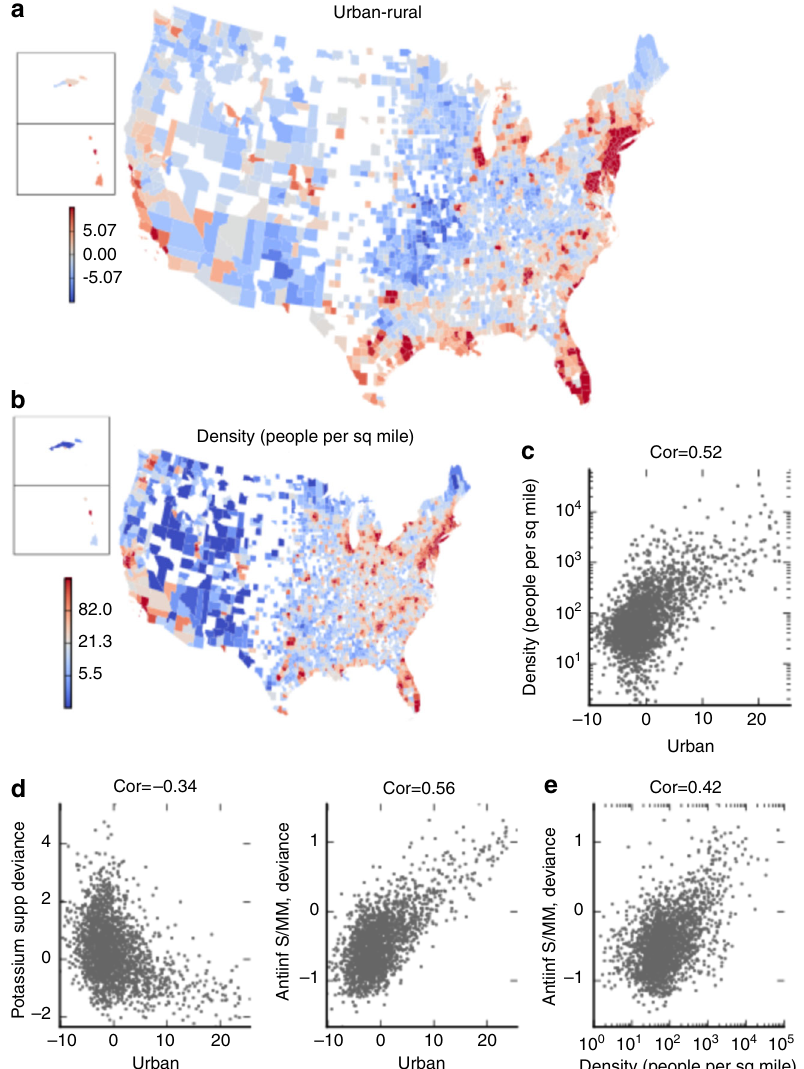
Fig. 2 Visualizing variance captured by Urban – Rural. a We project each county ’ s drug deviance vector onto the component, and map the projected values. The high values have a clear correspondence with urban centers in the USA. b Map of US population density per county. Colors are shown in a log scale (see legend). c Each point is a county, and the projected Urban – Rural value is compared with the population density in that county, with a Spearman correlation (abbreviated, cor) of 0.52. d Each county ’ s drug deviance value for a class of drugs is compared with the Urban projection value. A positive drug deviance represents more drug used in a county than expected. An example of a negatively correlated class is potassium supplements, typically used for people on potassium-depleting thiazide diuretics. The class Antiinf S/MM consists of dermatological topicals for skin in fl ammations, such as acne. e Directly compares the demographic characteristic from c with the drug class from